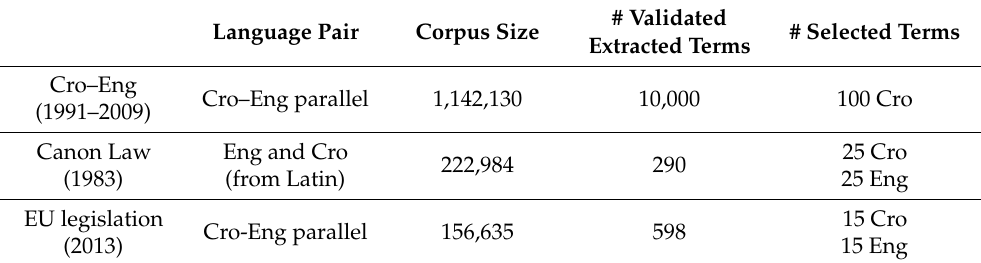
Table 2. Extracted and validated